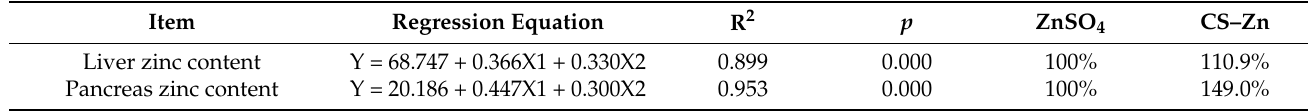
Table 5. Relative bioavailability of CS–Zn based on multiple linear regression of zinc content in the liver and pancreas. Item Regression